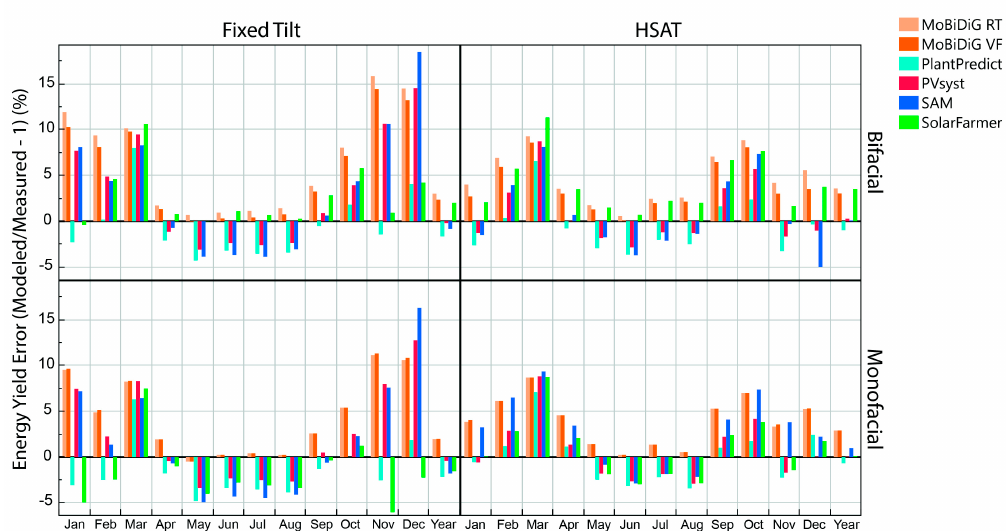
Figure 16. Monthly and yearly errors in energy yield (MWh) predictions from six software simulating four PV system types.